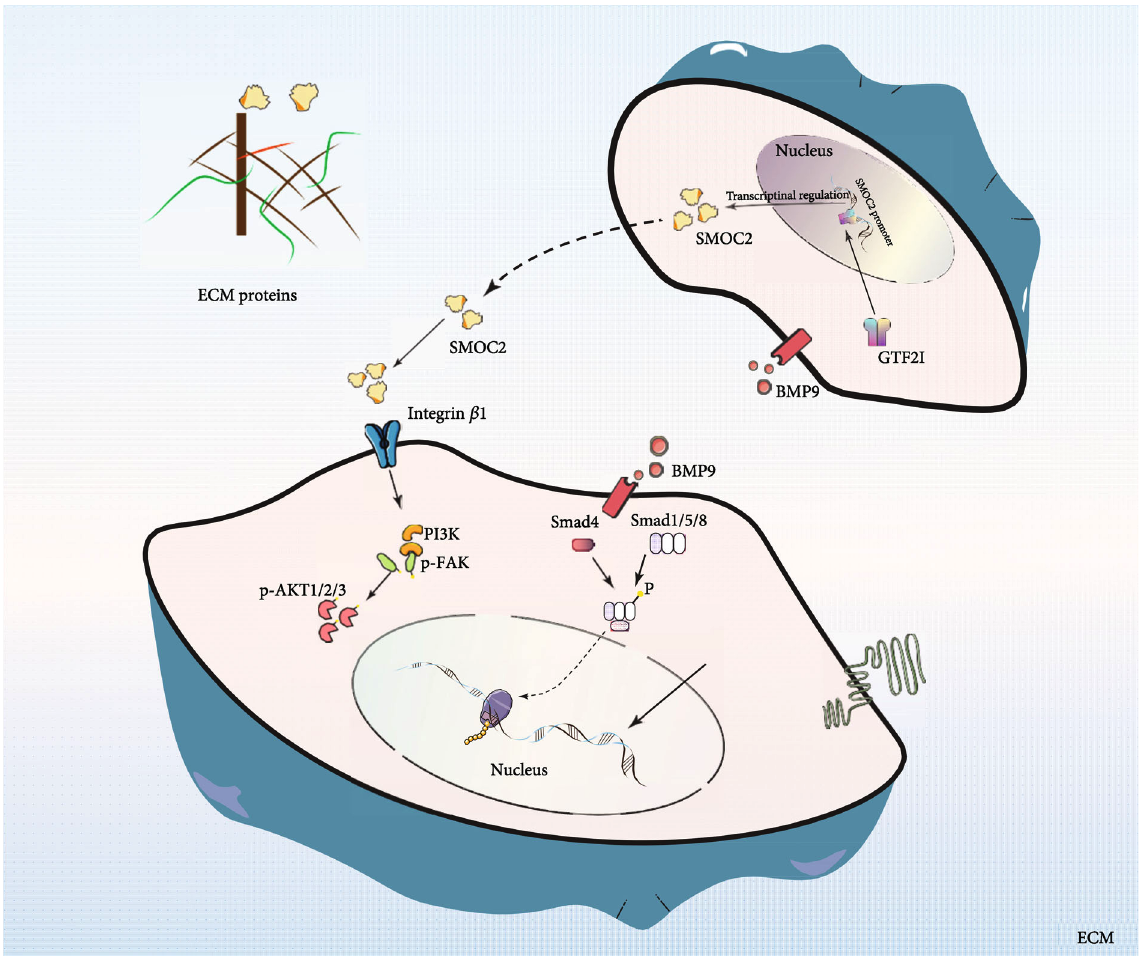
Figure 7: Mechanisms of action of SMOC2 in BMP-induced osteogenic di ff erentiation. The activation of FAK/AKT signaling may be triggered by facilitating the interaction of SMOC2 and integrin β